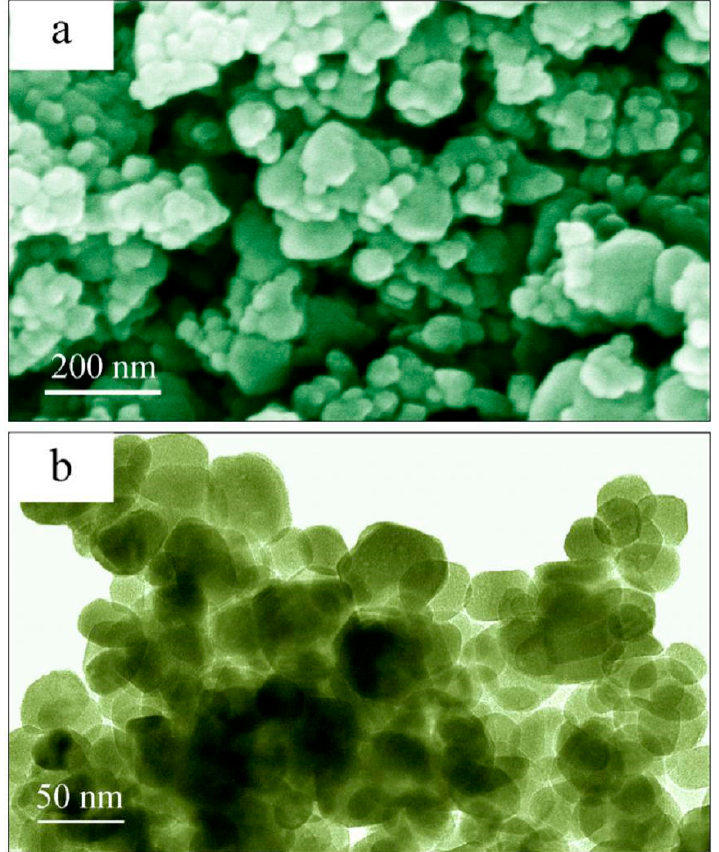
Figure 1. X-ray diffraction (XRD) curve of undoped ZnO nanocrystals and its Rietveld analysis.